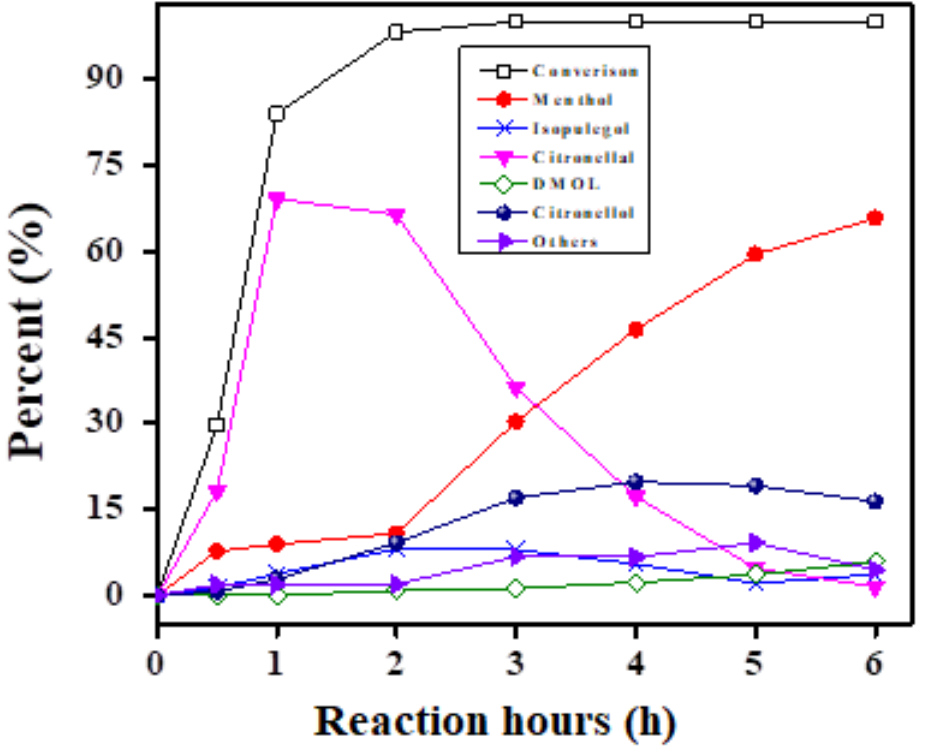
Figure 13. Product distribution of citral hydrogenation reaction over Ni-supported hierarchical USY catalyst (Ni-HZ-USY80).